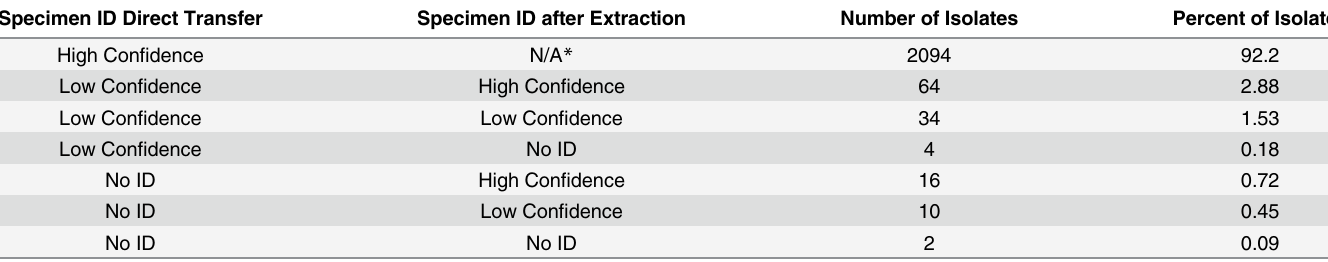
Table 5. Performance of extraction method MBT-CA for identification of Gram negative